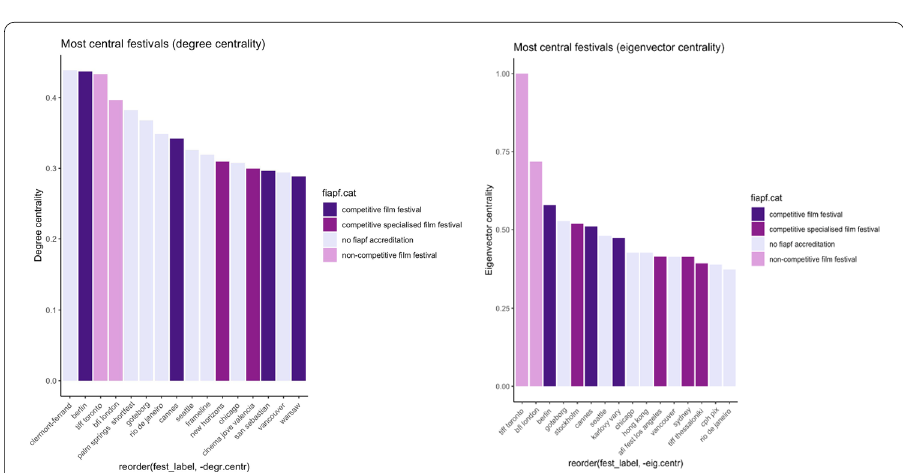
Fig. 5 Broker festivals based on top 99 percentile in distribution of degree and eigenvector